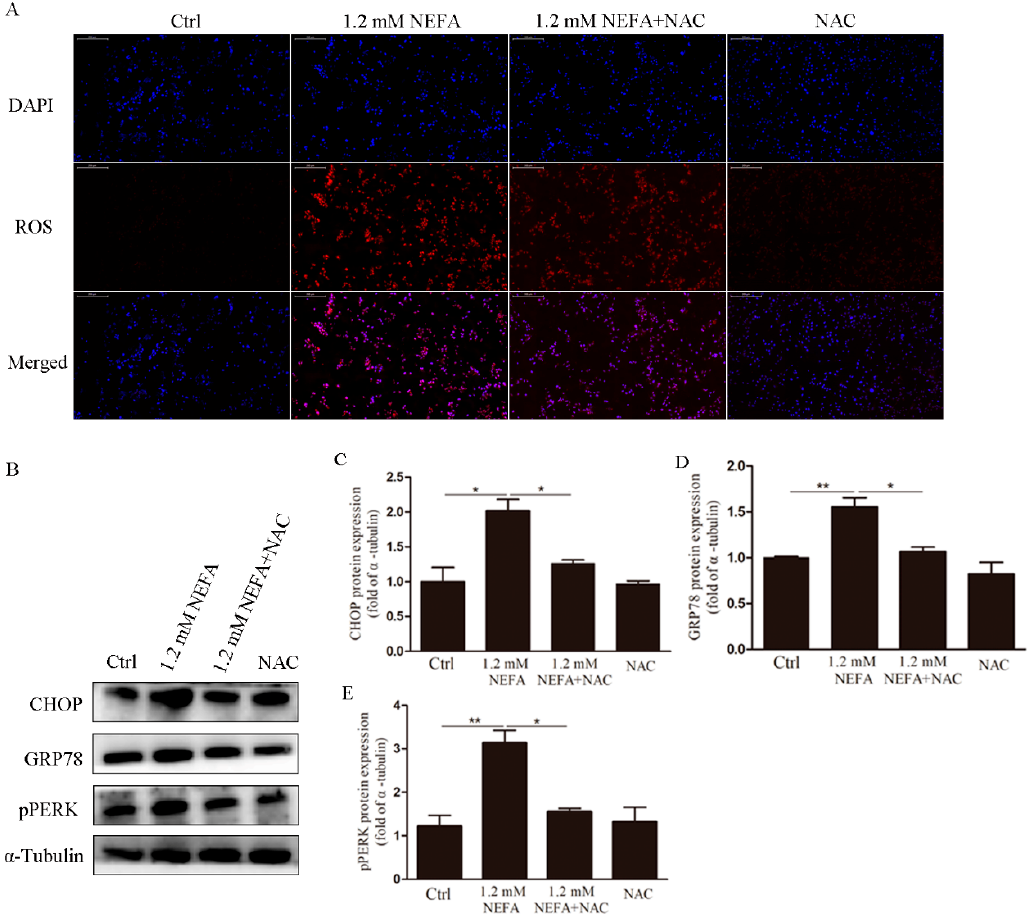
Figure 3. Treatment of N-acetyl-L-cysteine (NAC) in vitro attenuates ROS levels, ERS levels in NEFA treated GCs. ( A ) The accumulation of ROS was observed by immunofluorescence (scale bar, 200 μ m). The results showed that NAC inhibited the accumulation of ROS induced by NEFA. ( B – E ) Western blotting showing protein expression levels of CHOP, GRP78, and p-PERK, which indicate that NAC inhibited ERS. Data are presented as mean ± SEM, * p < 0.05, and ** p < 0.01.